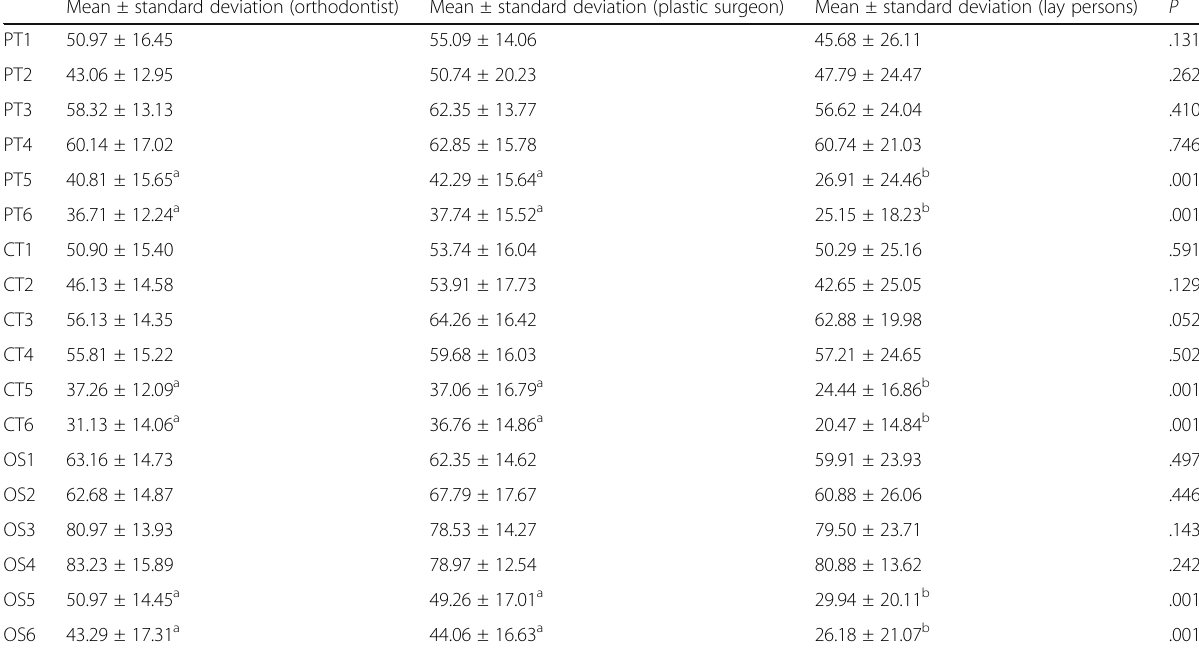
Table 2 Comparison of attractiveness scores among the groups Mean ± standard deviation (orthodontist) Mean ± standard deviation (plastic surgeon)